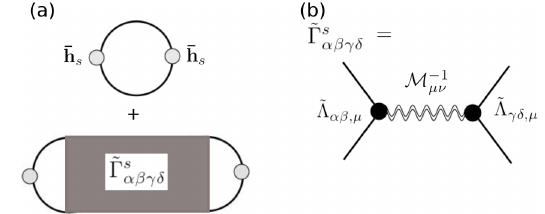
FIG. 2. (a) Diagrammatic representation of the susceptibility [Eq. (59)]. The thick solid line indicates the Nambu fermionic propagator. The gray circle corresponds to the fluctuation basis ¯ h , and the gray square corresponds to the quasiparticle inter- s ˜ Γ s action vertex αβγδ . (b) Diagrammatic representation of the ˜ Γ s quasiparticle interaction vertex αβγδ [Eq. (64)]. The double wavy line corresponds to the dressed bosonic propagator con- taining the infinite summation of the particle-particle or the particle-hole fermionic bubbles. The black circle denotes the ˜ Λ three-leg vertices αβμ (see main text for details).